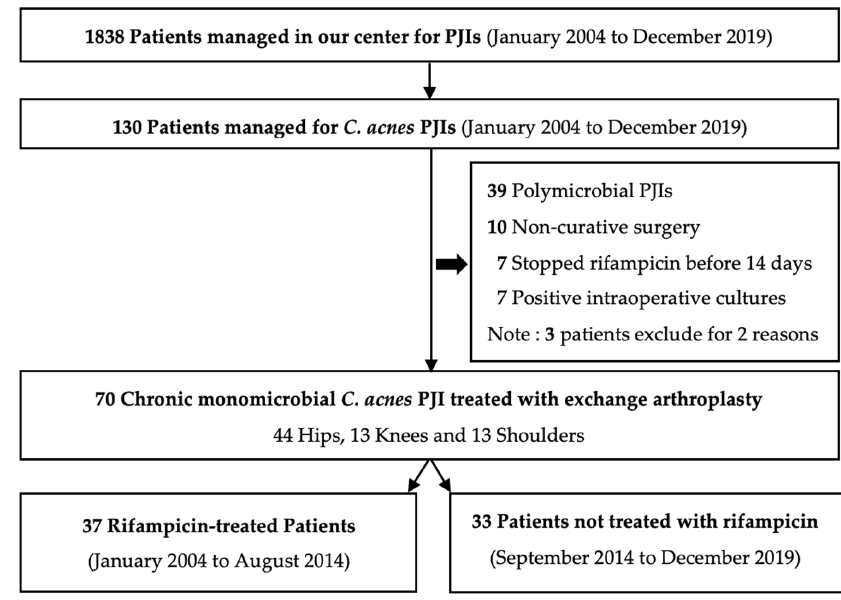
Figure 1. Ca-PJIs, Cutibacterium acnes prosthetic joint infections. Table 1. Baseline clinical characteristics of 70 patients treated for chronic Cutibacterium acnes PJIs with rifampicin or without.